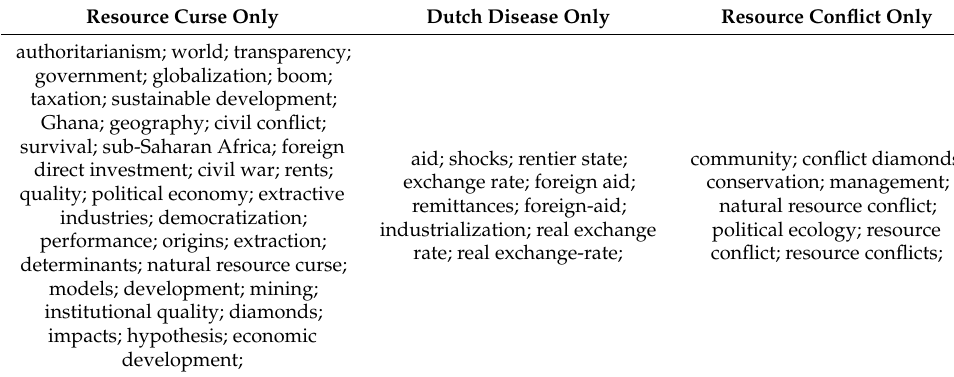
Table A2. Keywords purely from one string of the